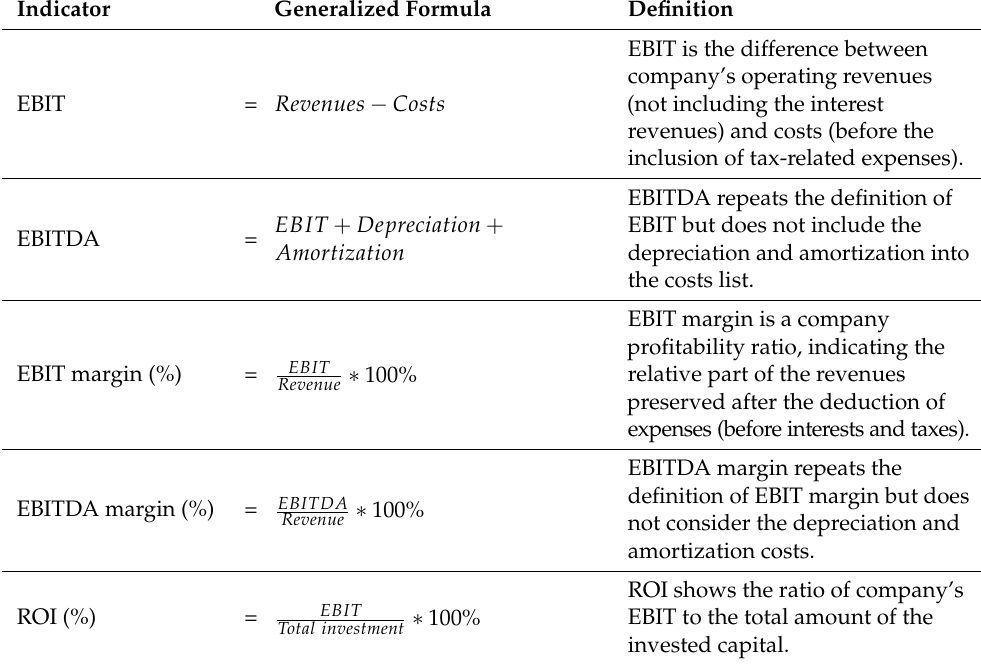
Table 2. Profitability indicators with definitions